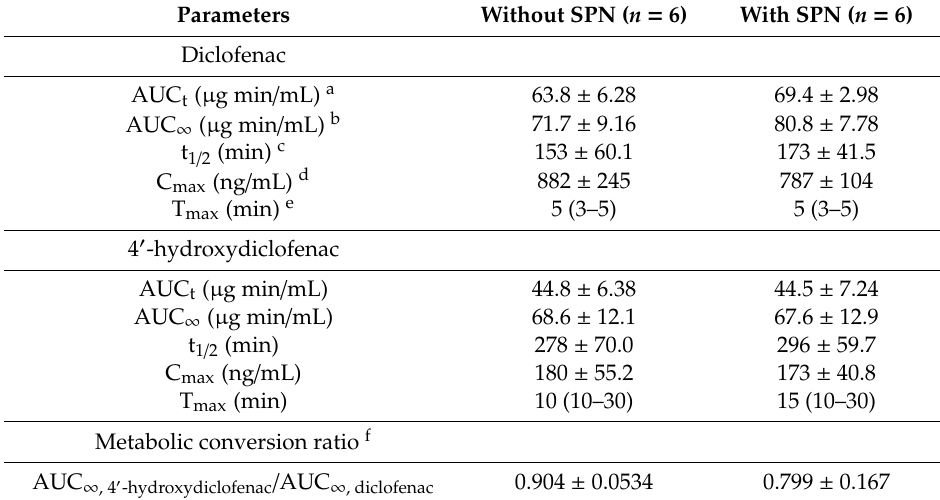
Table 3. Mean( ± standarddeviations)pharmacokineticparametersofdiclofenacand4 (cid:48) -hydroxydiclofenac after oral administration of diclofenac at a dose of 2 mg / kg without or with oral administration of SPN (75 mg / kg) to